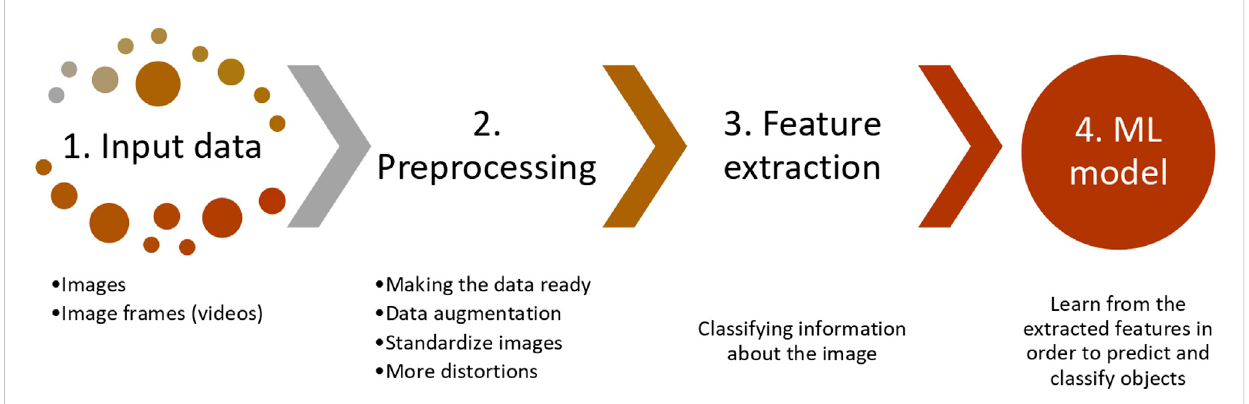
FIGURE 1 Computer vision pipeline.